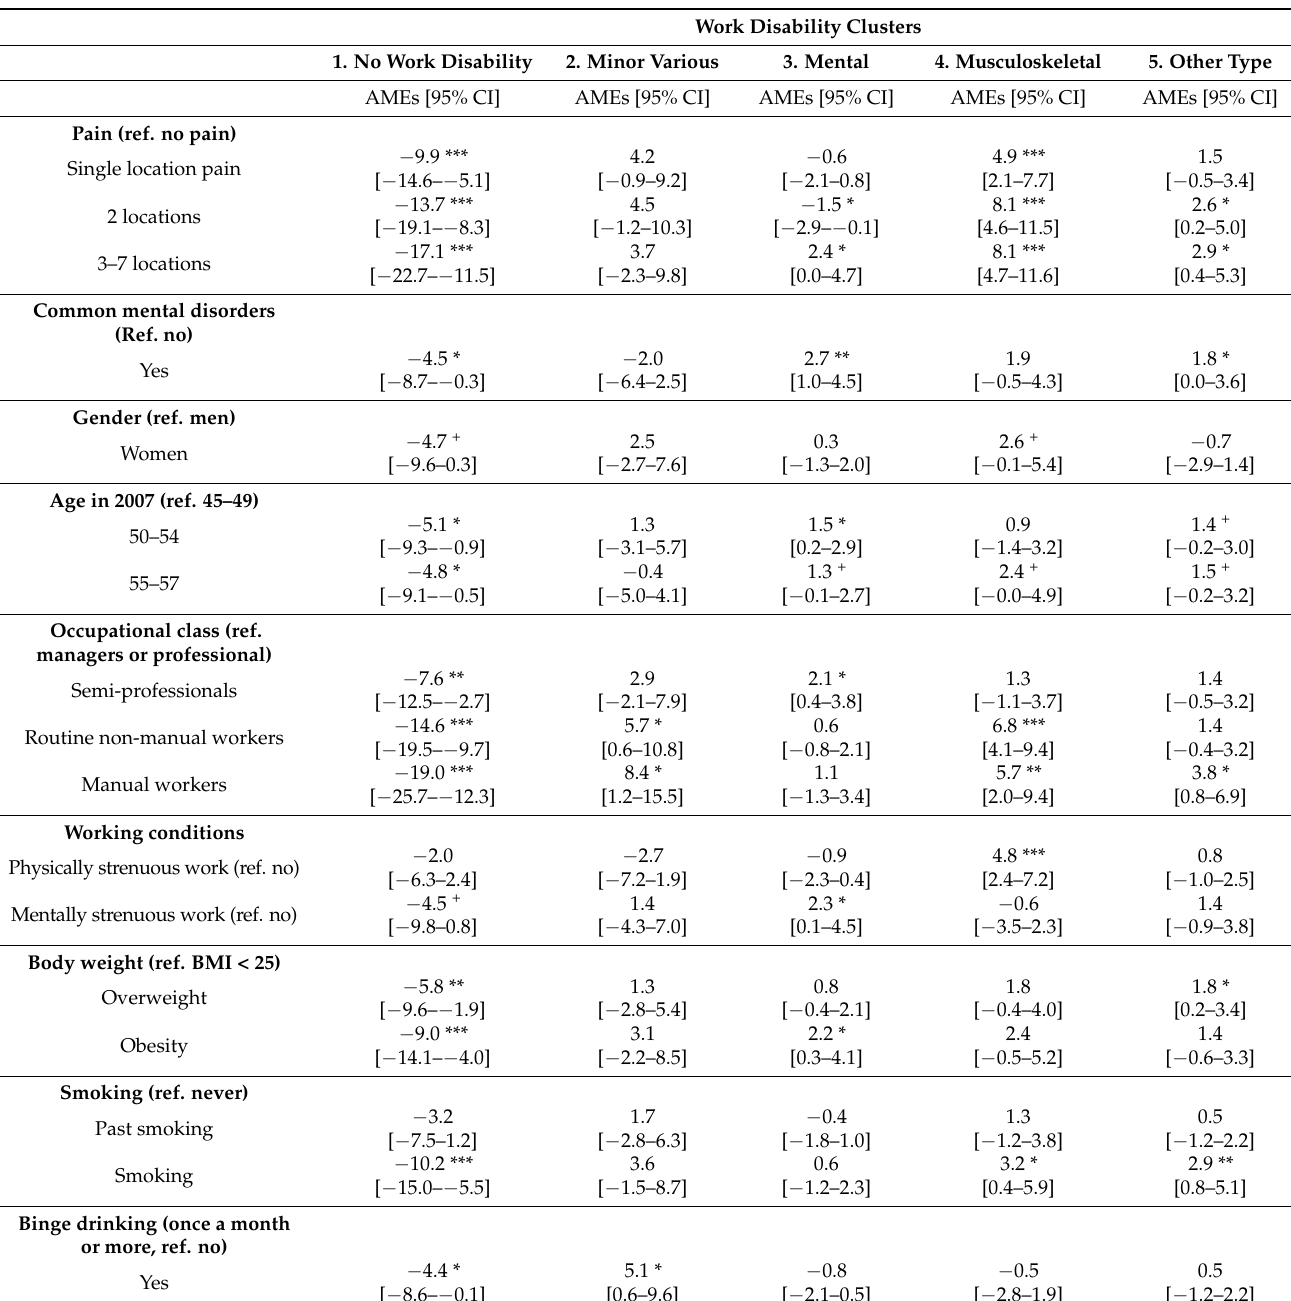
Table 3. Predictors of the work disability clusters. Average marginal effects (AME) and their 95% confidence intervals from multinomial logistic regression. N = 2878. Missing values are